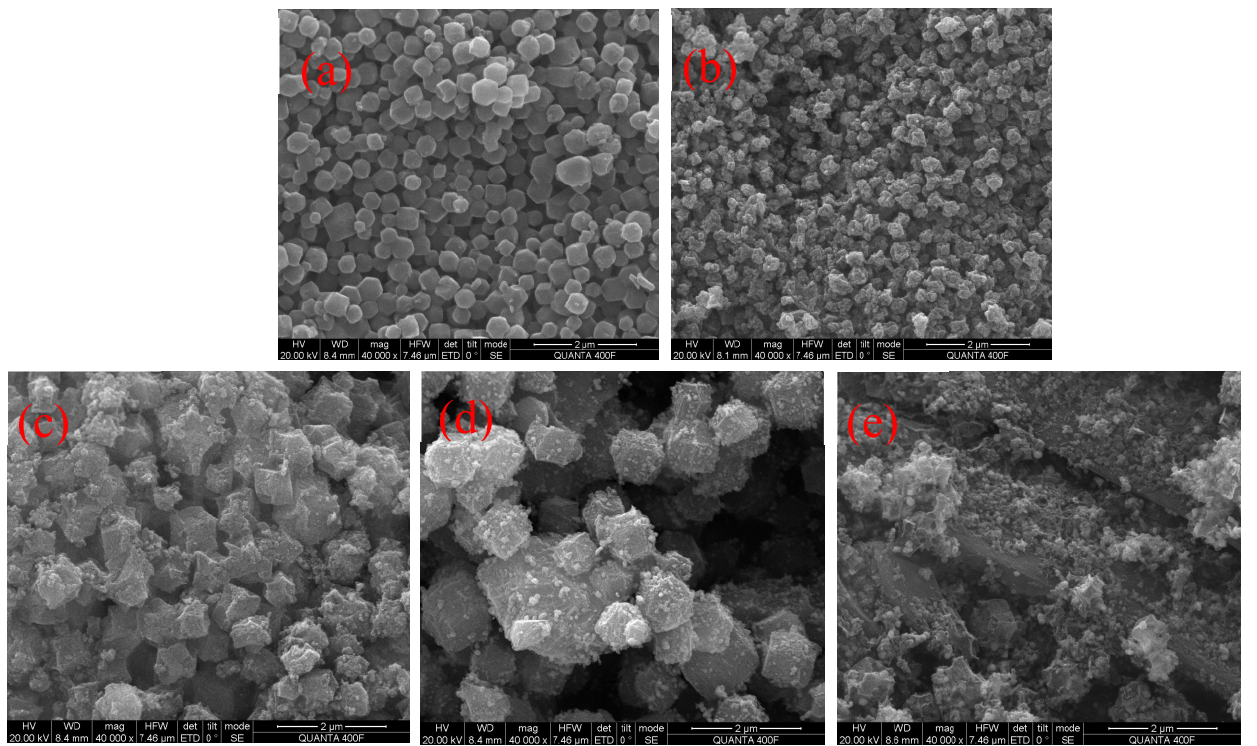
Figure 2. The SEM image of ZIF-67 ( a ), roasted ZIF-67 ( b ), straw-ZIF-67 composite ( c ), ionic liquid biochar-ZIF-67 composite ( d ), and pyrolysis biochar-ZIF-67 composite ( e ).